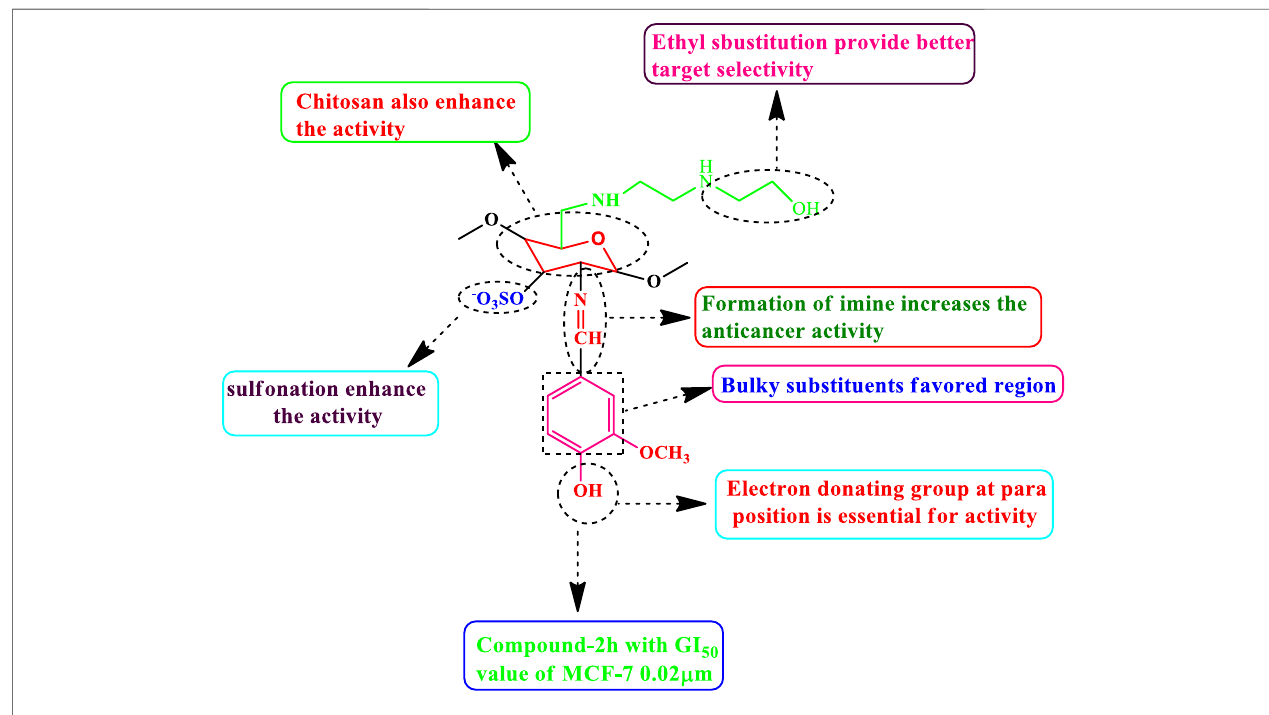
FIGURE 16 | SAR of highly active